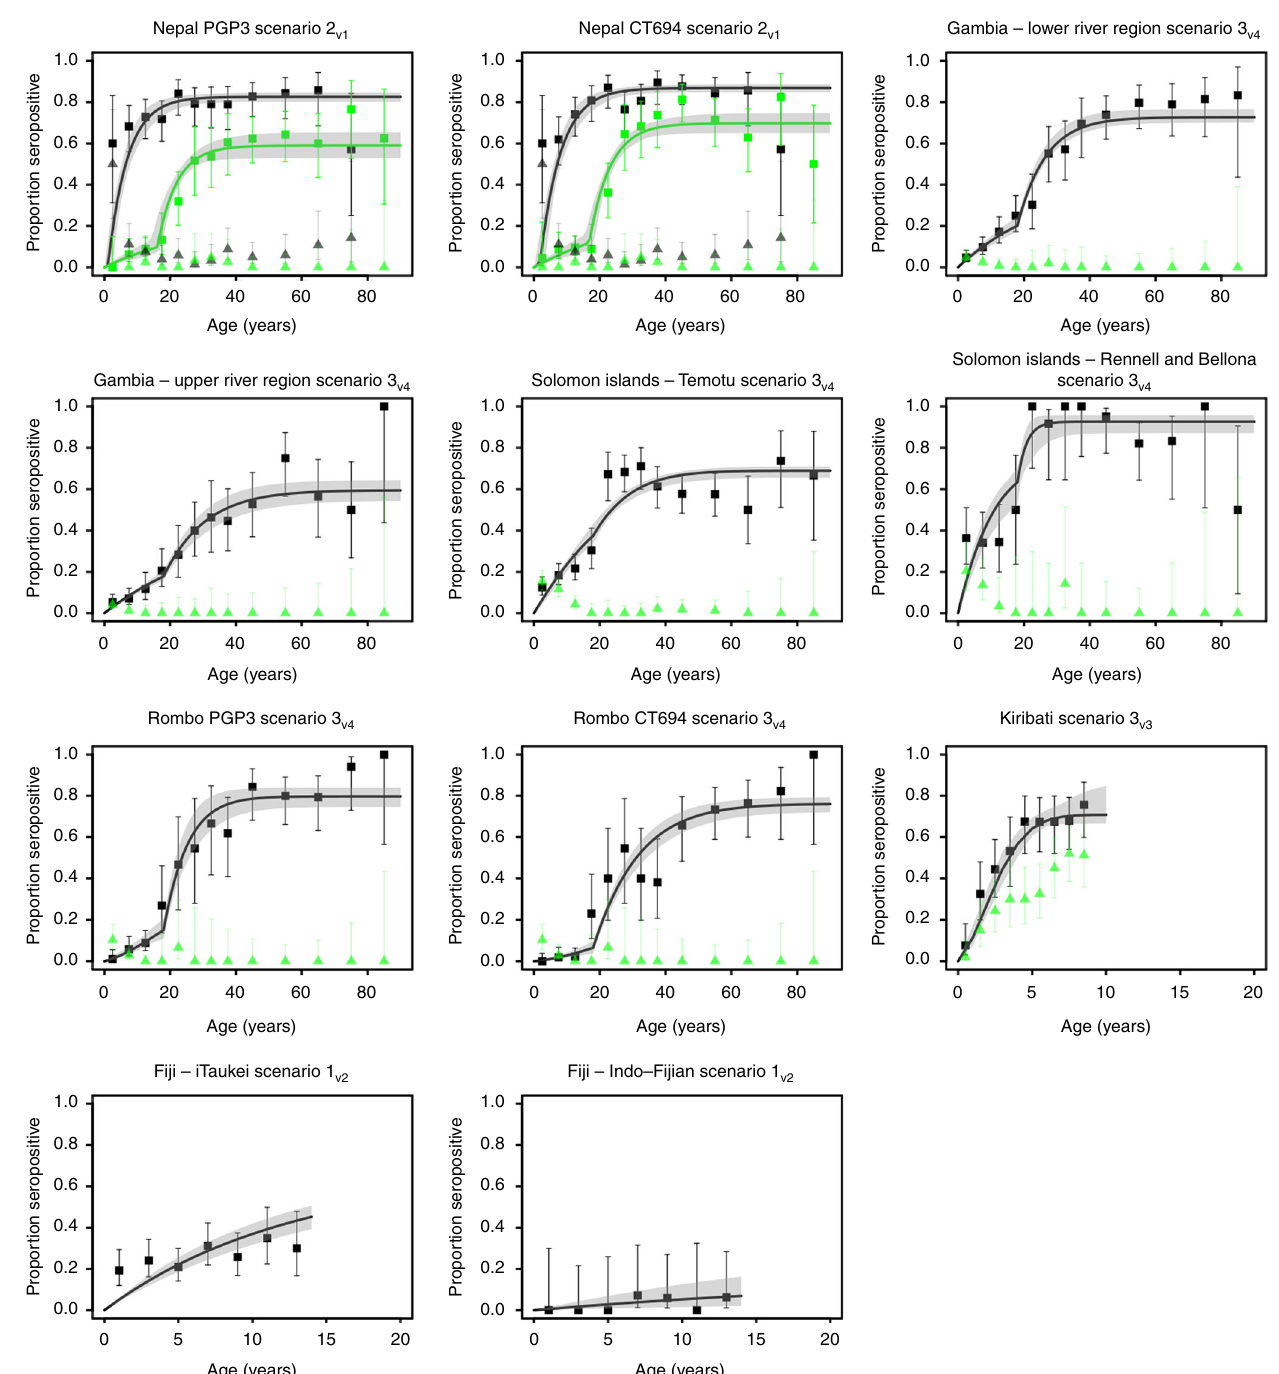
Fig. 1 Fits of the best-performing sero-catalytic models to age-speci fi c sero-prevalence data. The titles within each panel indicate the study site, antigen- speci fi c antibody responses measured and the best fi tting transmission scenario for that dataset. Black squares indicate the proportion sero-positive in each age-group and green triangles indicate the age-group speci fi c TF prevalence. Black and green data points on the Nepal plots indicate pre and post- MDA, respectively. Error bars on the squares and triangles indicate the 95% binomial con fi dence intervals. Solid black lines running through the sero- prevalence data were generated with the median parameter estimates from each model fi t. The shaded grey region represents the 95% credible intervals of the model predictions. Uncertainty was generated by drawing 500 independent samples from the posterior distribution